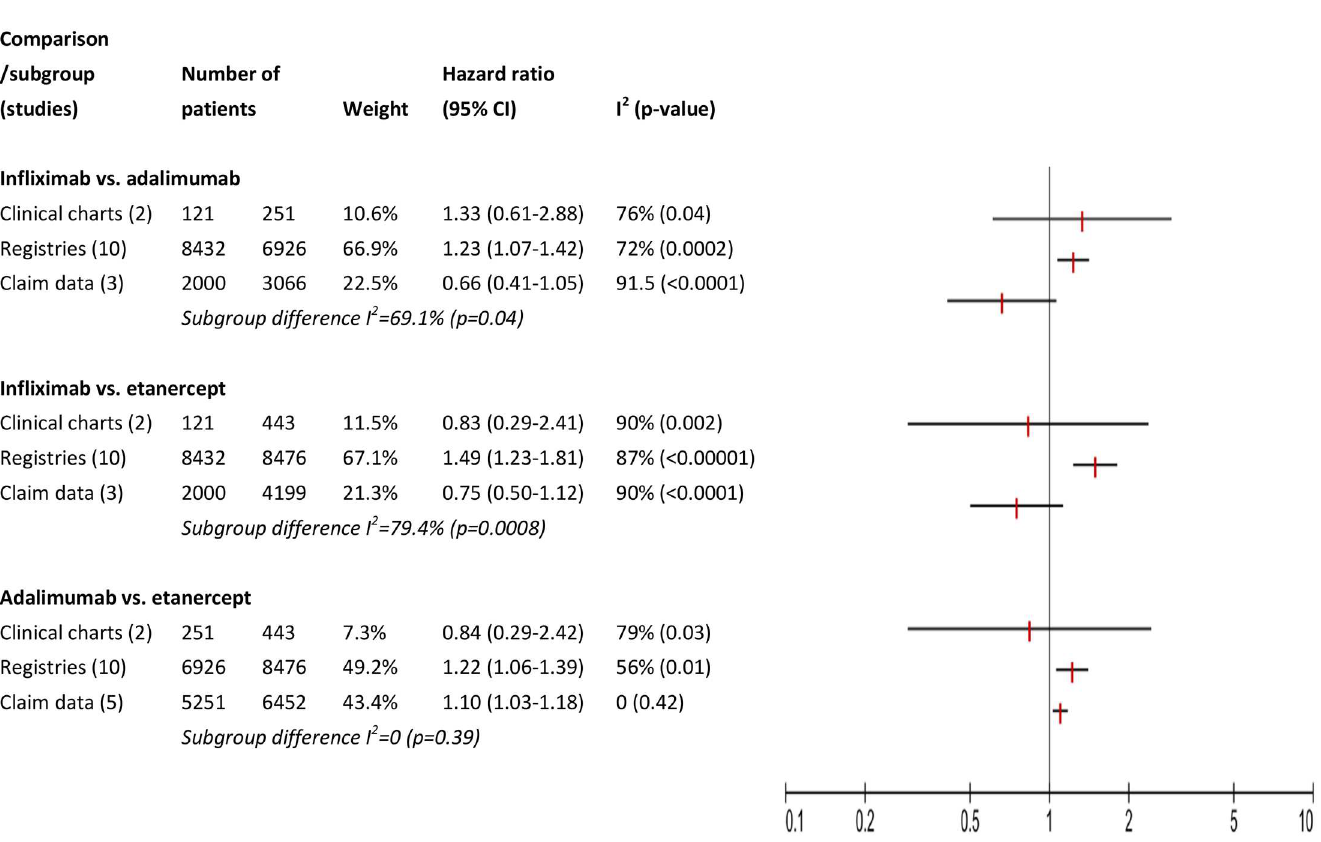
Fig 2. Assessment of methodological heterogeneity: subgroup analysis for type of data.